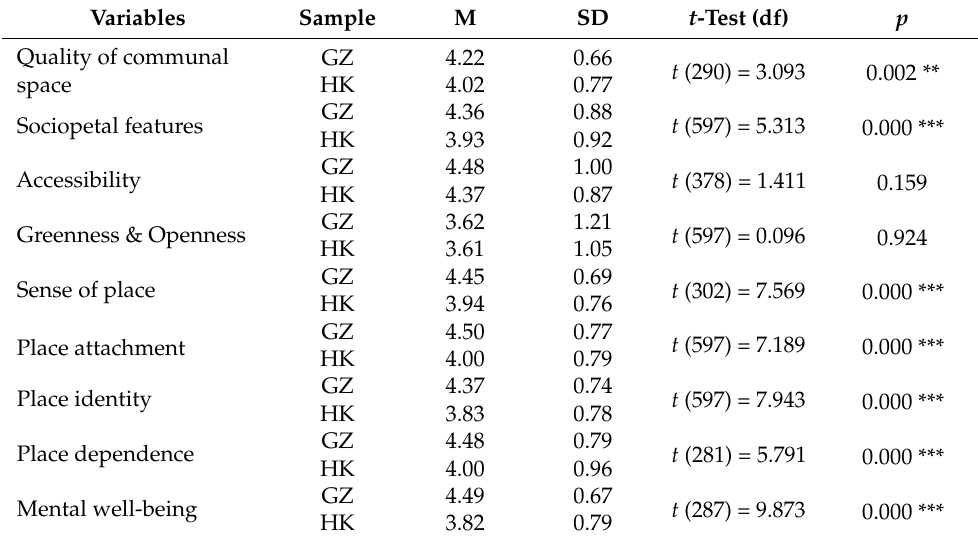
Table 2. Descriptive Statistics of the younger samples (N GZ = 422, N HK =